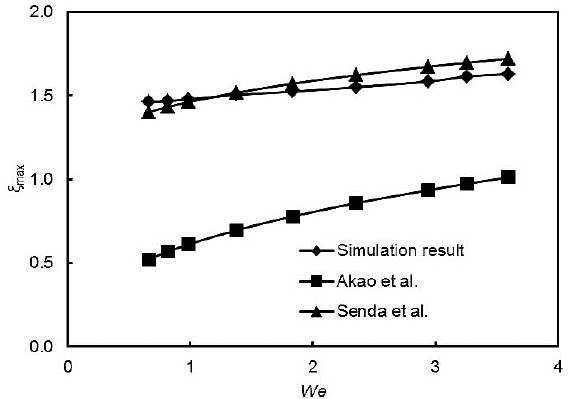
Figure 8. Comparison of the maximum deformation ratio by the experimental result and the prediction models.